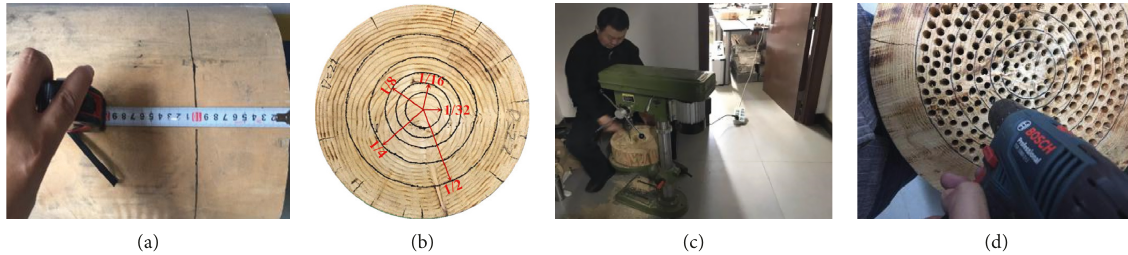
Figure 2: Fabrication of test specimens: (a) sawing; (b) damage ratio; (c) manual digging; (d) manual